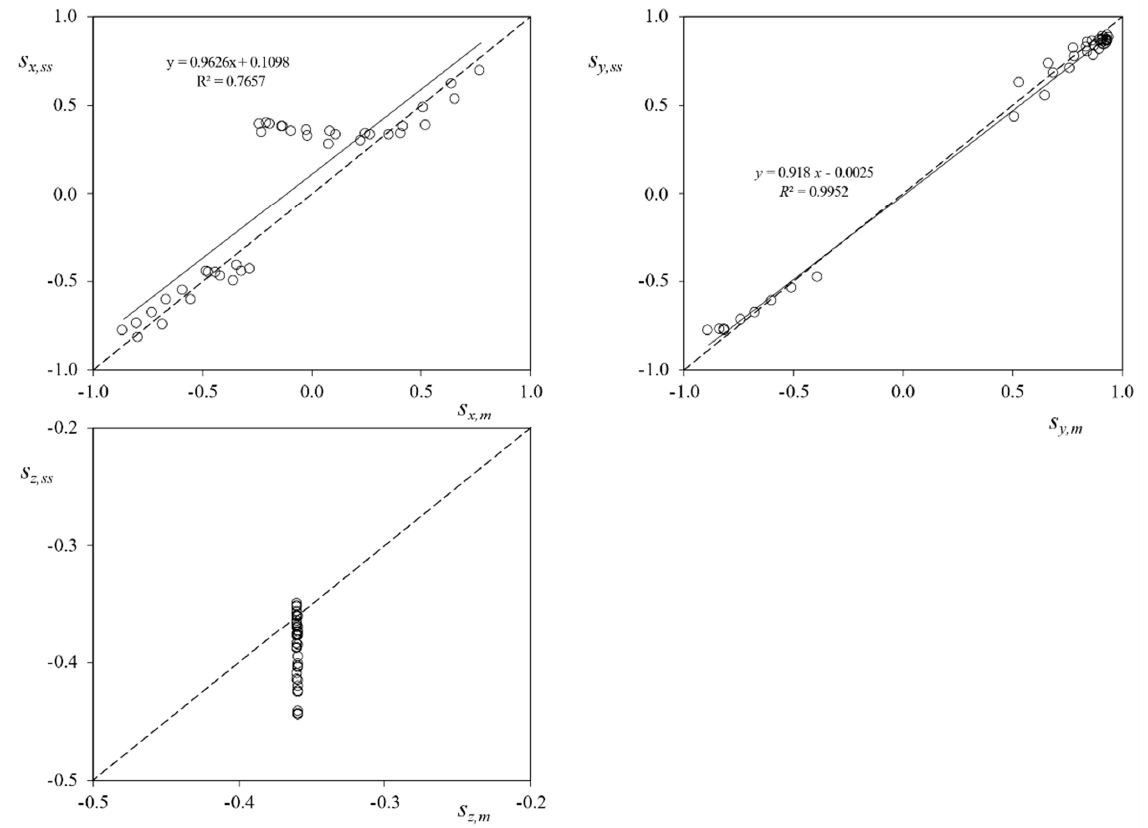
Figure 15. Sun direction coordinates with regard to the UPMSat-2, reference system. Coordinates based on the sun sensors system ( s x,ss , s y,ss , and s z,ss ) vs. coordinates based on the magnetometers of the satellite’s ADCS ( s x,m , s y,m , and s z,m ). A larger error is observed regarding the z -axis. This is caused by the method used to derive the satellite attitude from the magnetometer data, and the performance of the pho-